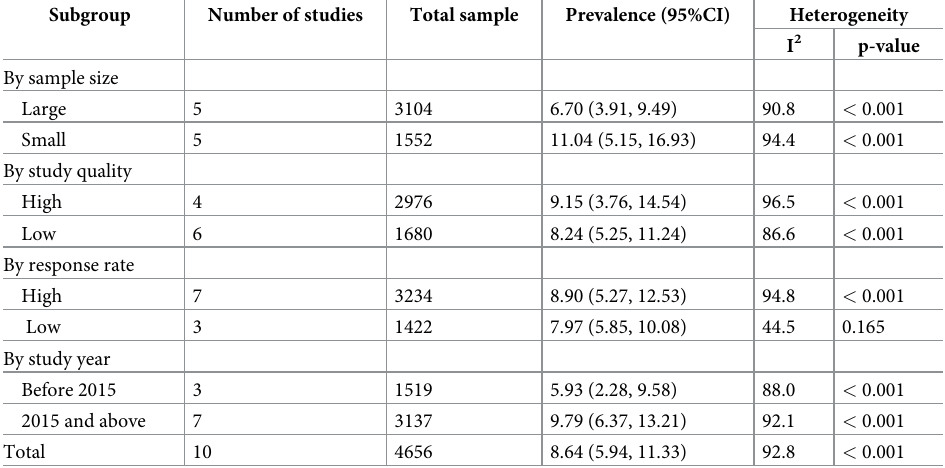
Table 2. Subgroup analysis of the prevalence of induced abortion at higher education institutions in Ethiopia,